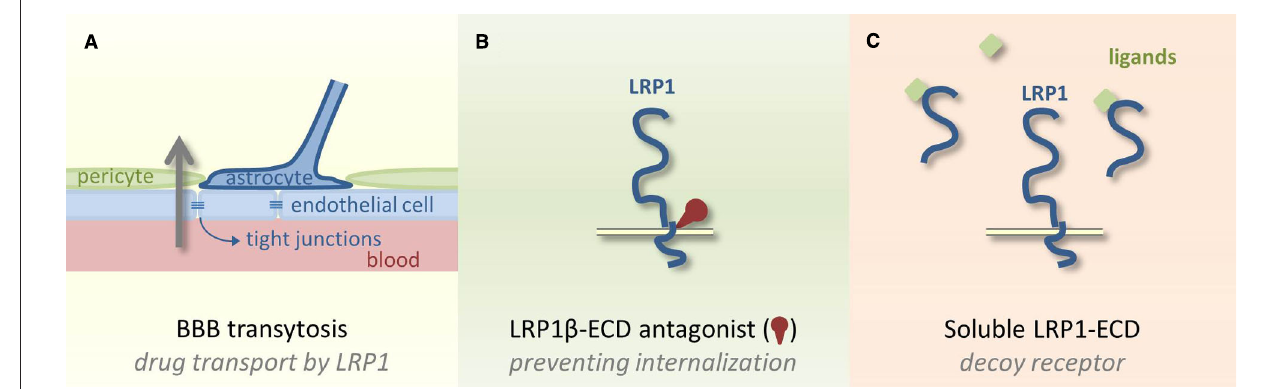
FIGURE 2 | Potential clinical applications of LRP1. (A) Using LRP1 as a cargo receptor to sluice chemotherapeutic agents through the tightly controlled blood–brain barrier via transcytosis is undergoing clinical testing. (B) LRP1 antagonists to the ECD could prevent LRP1 internalization and catabolization. (C) The ECD of LRP1 could also be used as a soluble decoy receptor to capture LRP1 ligands and avoid ligand-receptor